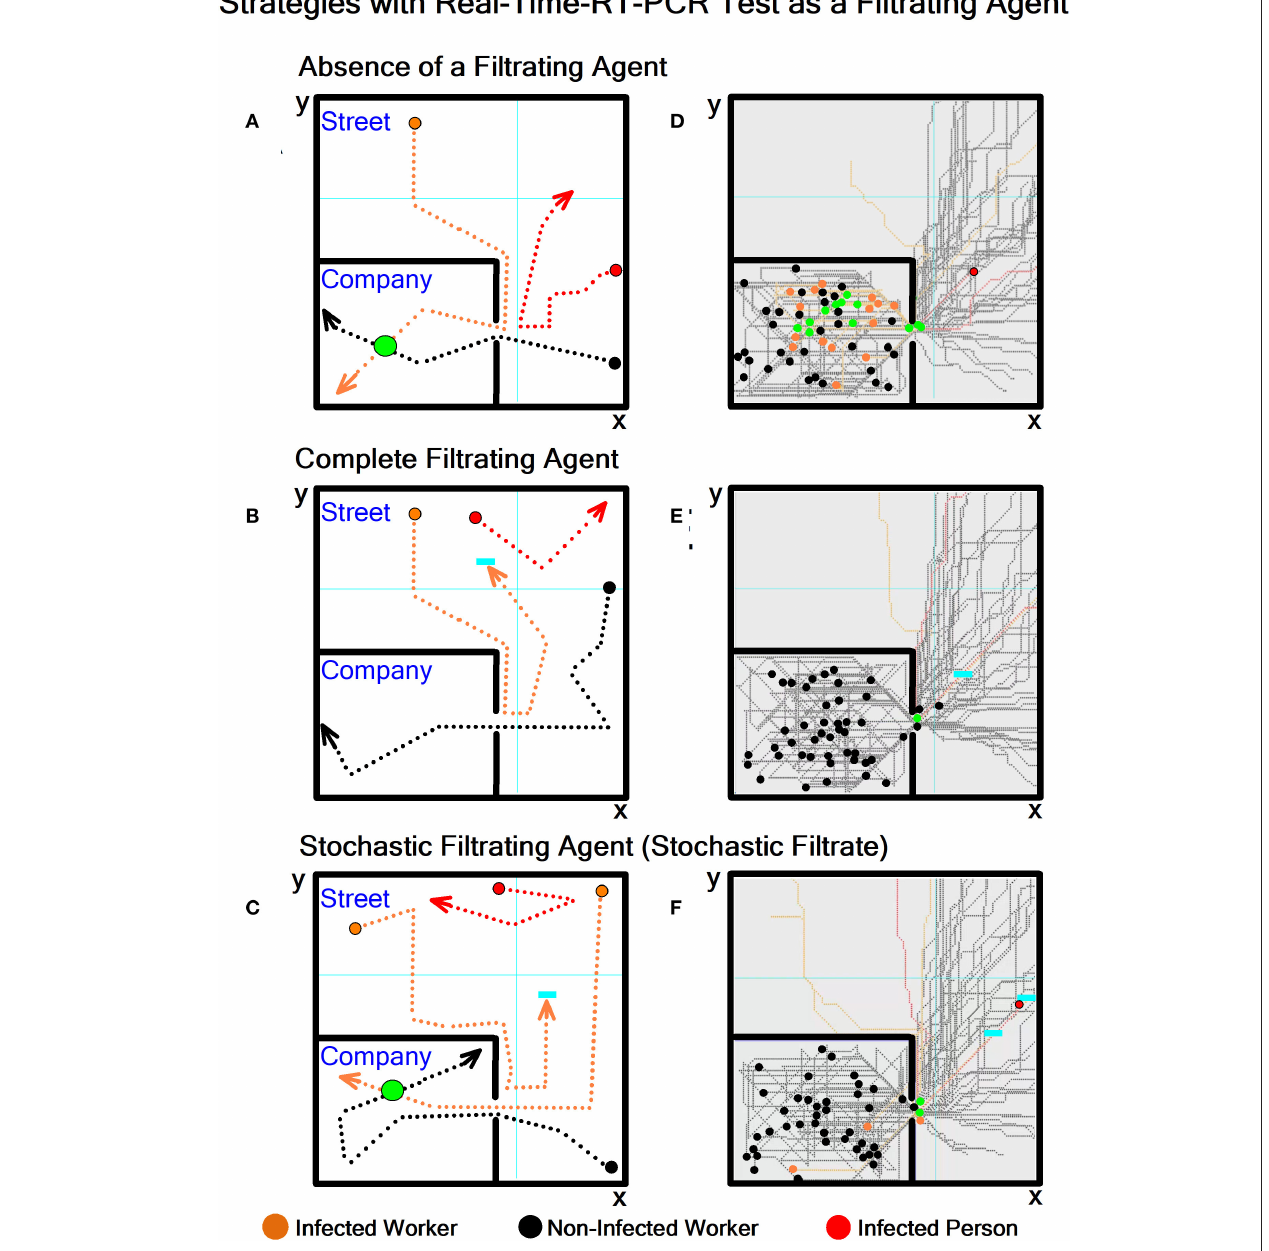
FIGURE 3 | Simulated strategies with real-time-RT-PCR as a filtrating agent. (A–C) Scheme of trajectories for two workers, one infected and another non-infected, and for one infected-person walking on the street. (D–F) The same as (A–C) , but for superimposed trajectories of 48 non-infected workers and one infected worker as initial conditions. In this case, there is also one infected-person walking on the street (more explanations in the text). Note that each approach yields different scenarios, with more contagions (orange circles) in situation (D) than in scenarios (E,F) . In the Supplementary Material , we included two movies and the Python code with detailed explanations (for purposes of reproducing or extending the analysis). The first movie simulates in sequence the three scenarios during 5 working days in real time: (D) Absence of a filtrating agent with RSS = 0%, (E) Complete filtrating agent RSS = 100%, and (F) Stochastic filtrating agent, where RSS = 40%. The second movie is similar to (D–F) , but for RSS = 75%. RSS is expressed as percentage of the total number of filtrating agents; i.e., when the filter is in the “complete filtrating agent” condition (see Figure 2 ).